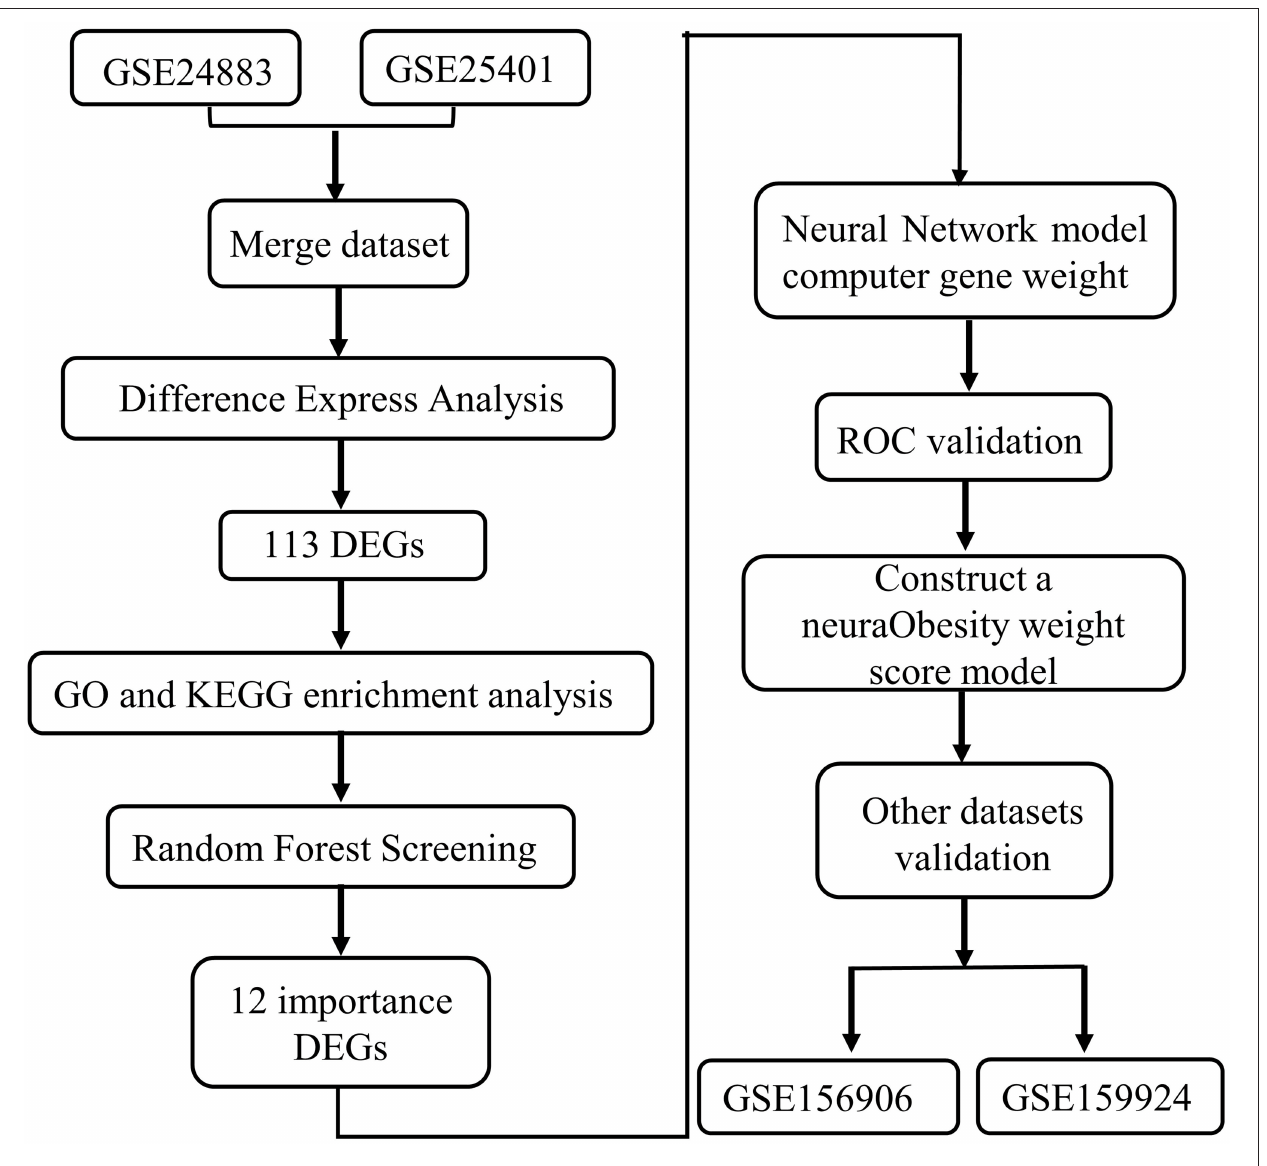
FIGURE 1 | Flowchart.